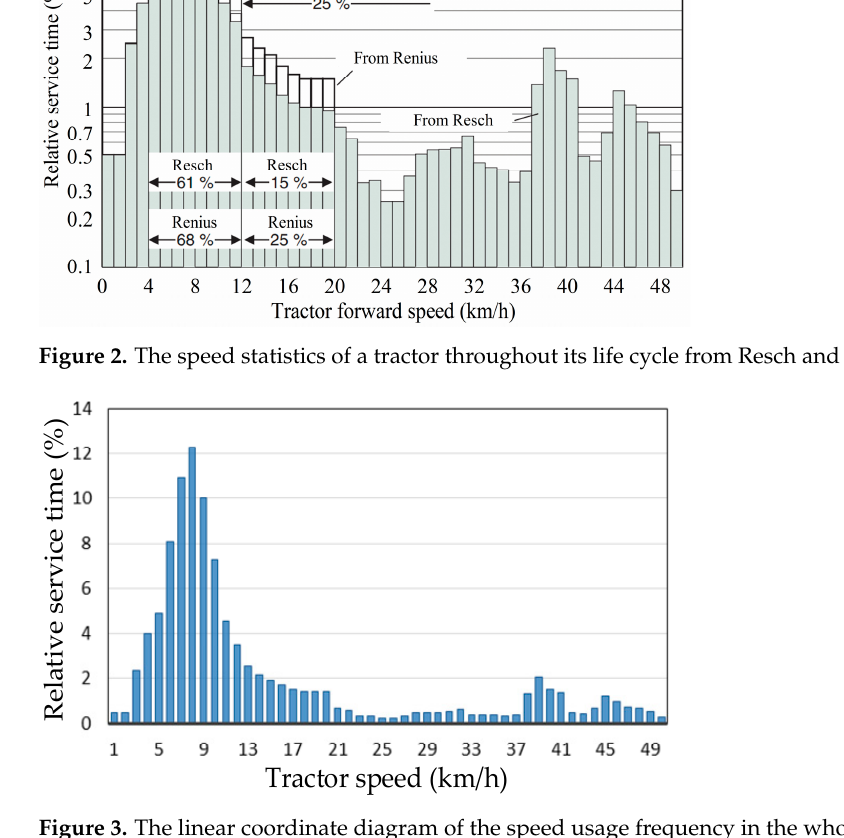
Figure 2. The speed statistics of a tractor throughout its life cycle from Resch and Renius [26].